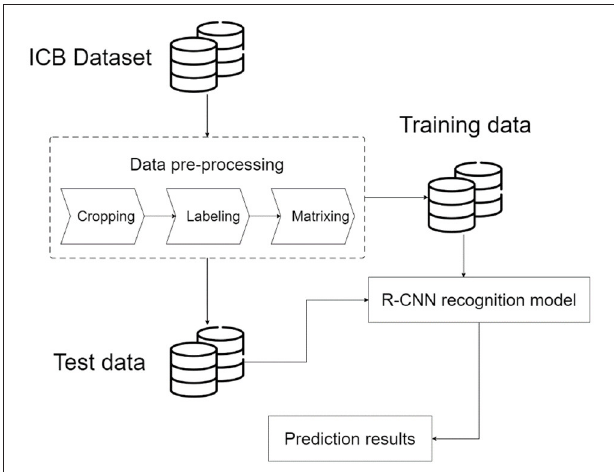
FIGURE 1 | Image recognition and object detection model for